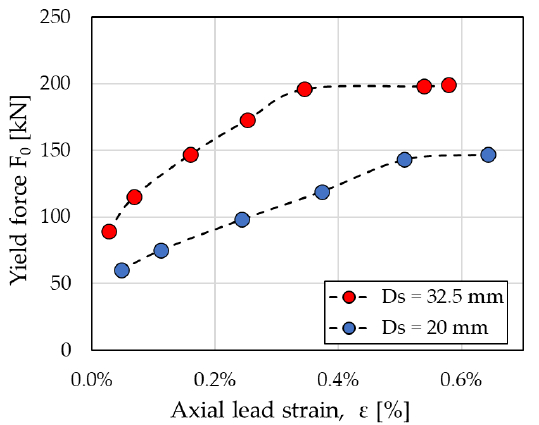
Figure 2. Effect of prestressing on the force of the PS-LED: yield force F 0 vs. axial strain ε of the lead core calculated in the numerical analyses considering a shaft diameter ( Ds ) of either 20 mm or 32.5 mm (adapted from ref. [3]).